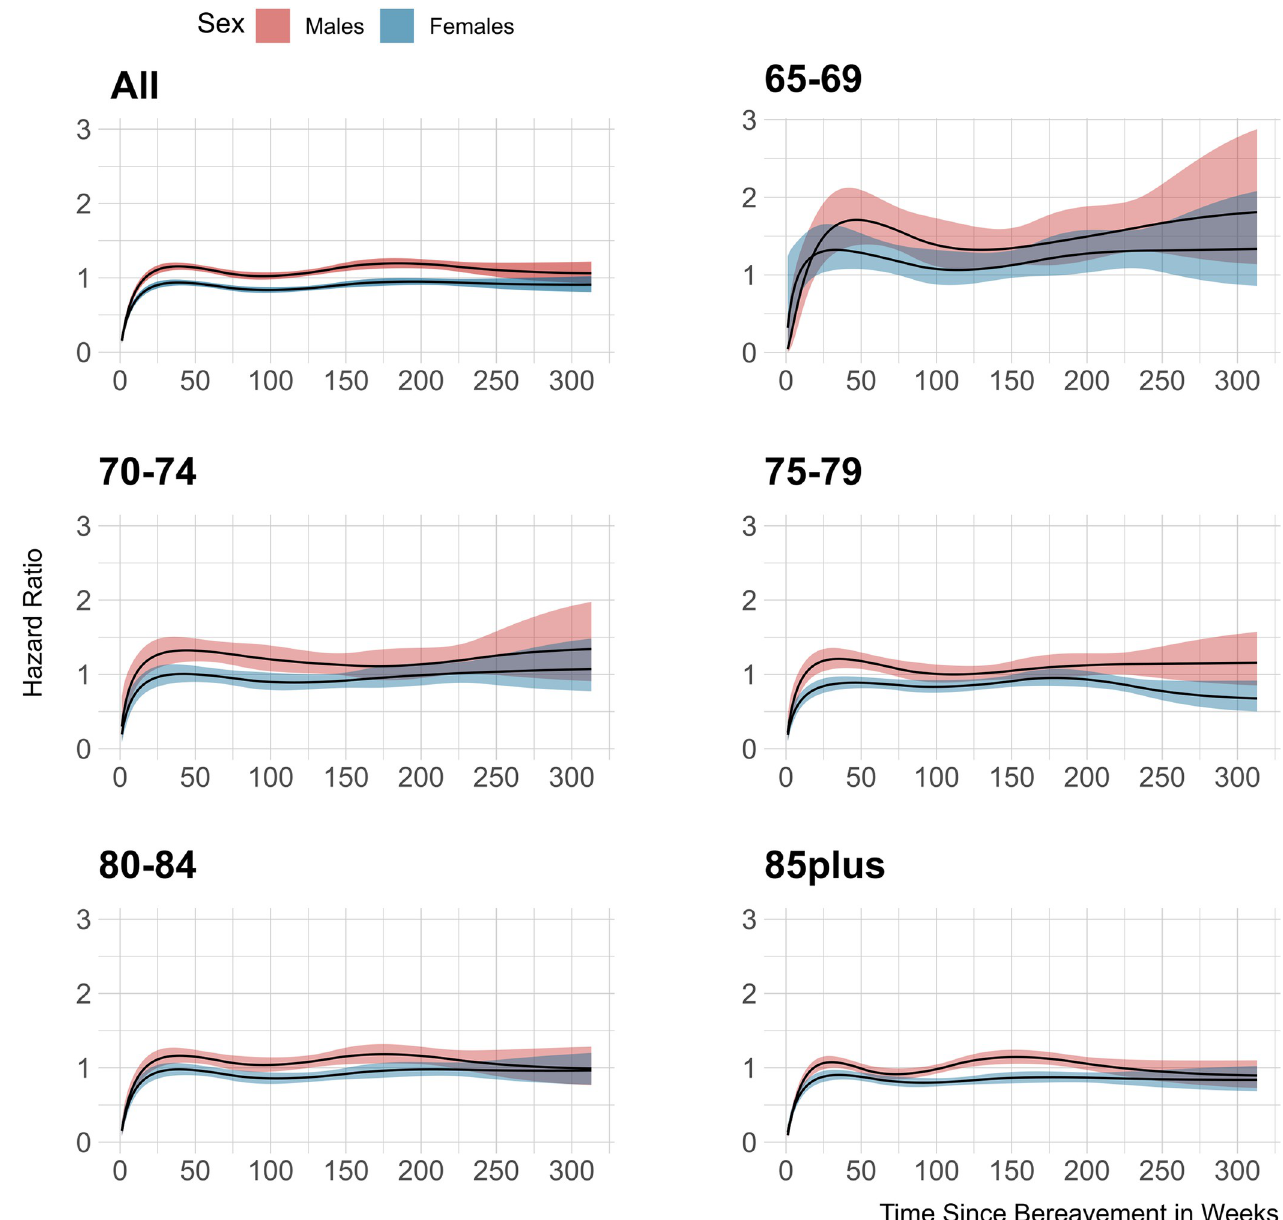
Fig 3. Sex and age stratified hazard ratios for all-cause mortality based on bereavement status. The panel on the top-left shows the overall hazard ratio for mortality as a function of time since bereavement for males and females respectively. The other panels show hazard ratios in various age strata.